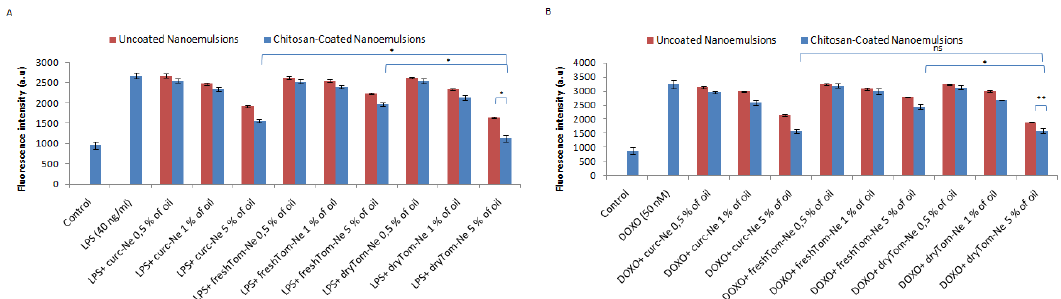
Figure 9. Intracellular calcium fluorescence staining in H9c2 cells (expressed as fluorescence intensity a.u). Cells were pretreated or not with uncoated and chitosan-coated nutraceutical-loaded nanoemulsions at 0.5%, 1% and 5% of oil for 4 h before stimulation with 40 ng/mL of LPS ( A ) or 50 nM of DOXO, ( B ) for 24 h. * p < 0.001; ** p < 0.05; ns: not significant.